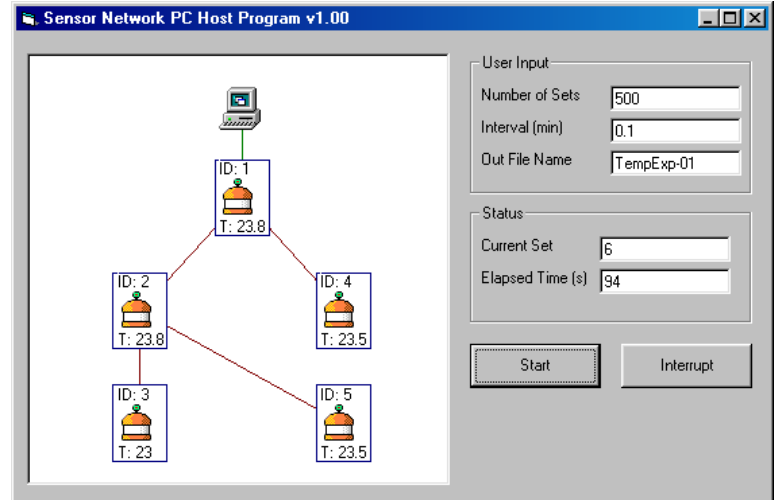
Figure 13. The user interface screen of the host PC software. The network configuration and real-time temperature reading is shown on the left of the screen (ID = Node identity, T = Temperature). The user can change the total number of data points (Number of Sets), time interval between each data points, and the output data file name via the text boxes on the left. After establishing the network configuration, temperature data from all nodes are collected and uploaded to the host PC every 6 seconds. The host PC saves the temperature data as a function of time